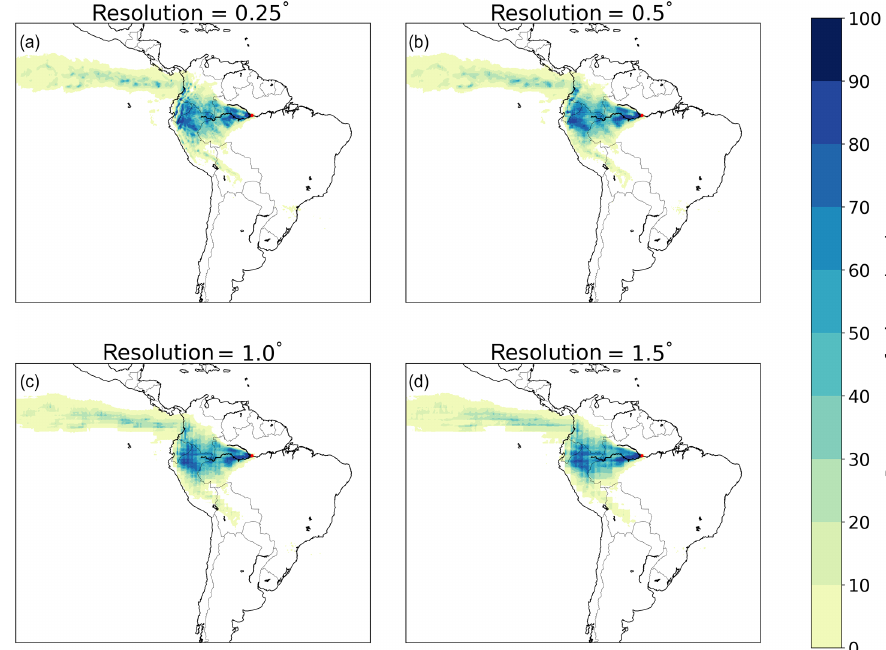
Figure 8. Different footprints of moisture releases from Manaus in July 2012 in a three-dimensional Lagrangian model with different horizontal resolutions. (a) 0.25 ◦ , with a mean latitudinal moisture flow of 1.5 ◦ in a northerly direction and mean longitudinal flow of 14.4 ◦ in a westerly direction; (b) 0.5 ◦ , with a mean latitudinal moisture flow of 1.6 ◦ in a northerly direction and mean longitudinal flow of 14.3 ◦ in a westerly direction; (c) 1.0 ◦ , with a mean latitudinal moisture flow of 1.7 ◦ in a northerly direction and mean longitudinal flow of 14.2 ◦ in a westerly direction; (d) 1.5 ◦ , with a mean latitudinal moisture flow of 1.7 ◦ in a northerly direction and mean longitudinal flow of 14.2 ◦ in a westerly